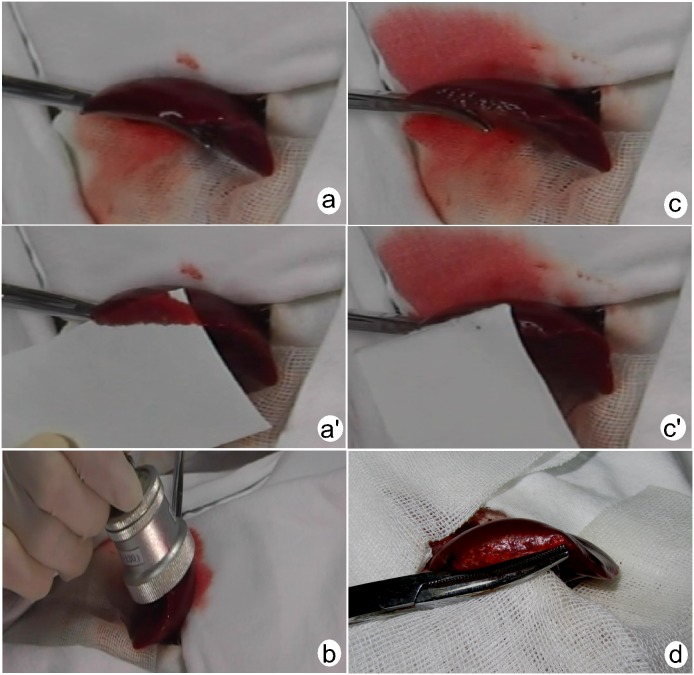
Images of procedure for application of microbubble-enhanced therapeutic ultrasound.
a’, active bleeding of the wound before insonation; b, Direct insonation of the wound by a transducer during injection of microbubbles; c, c’, small exudates over the wound after insonation; d, The liver wound were smooth and no bleeding after 48 h.